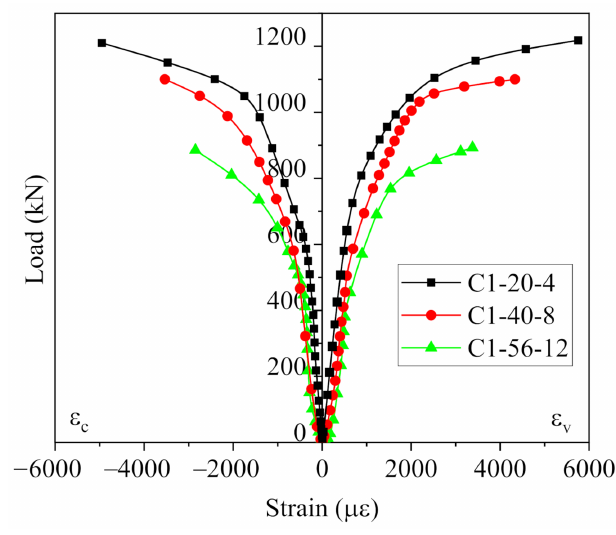
Figure 5. Load vs. strain